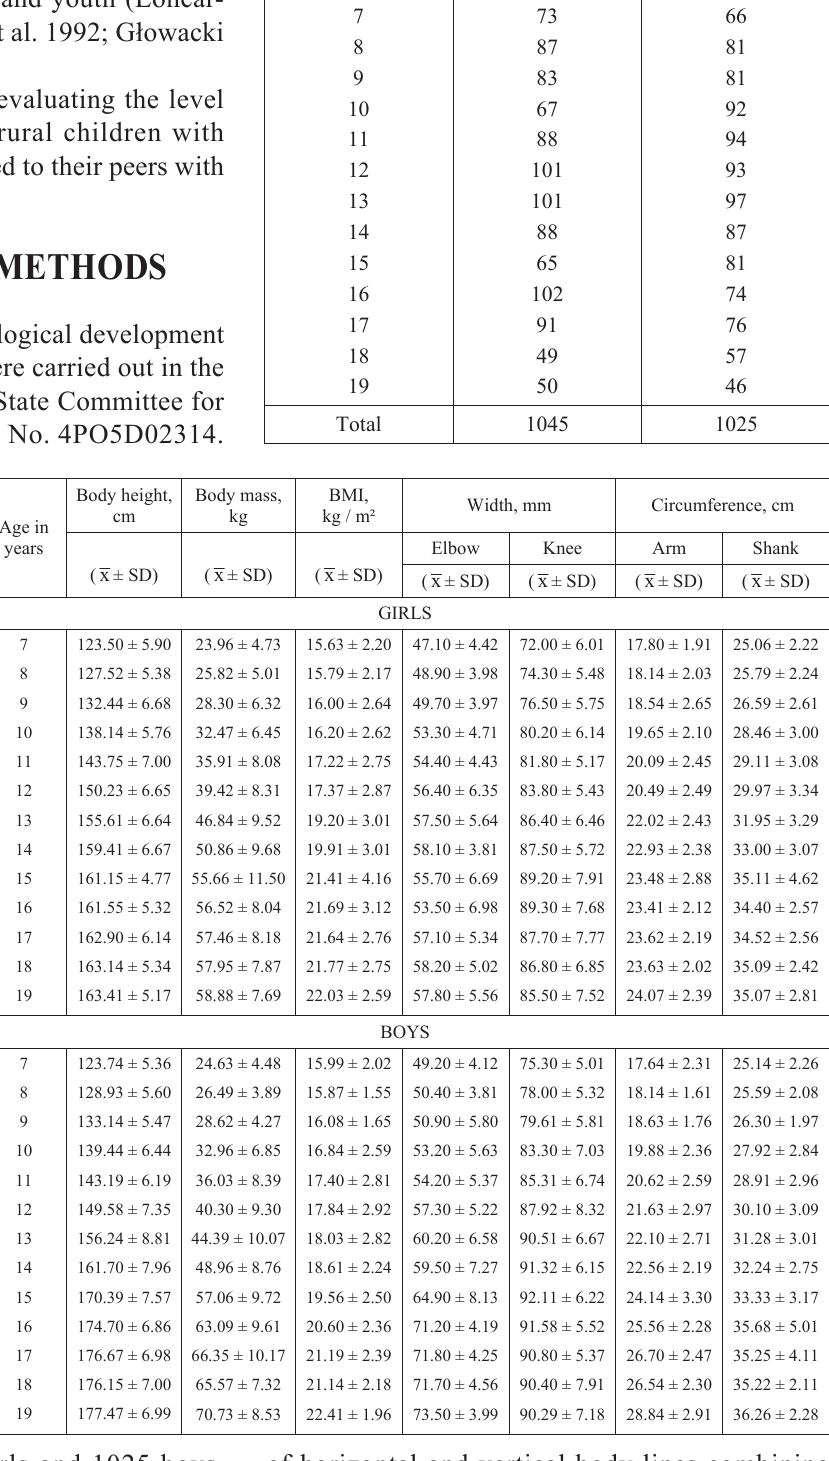
Table 1. The number of the rural girls and boys examined